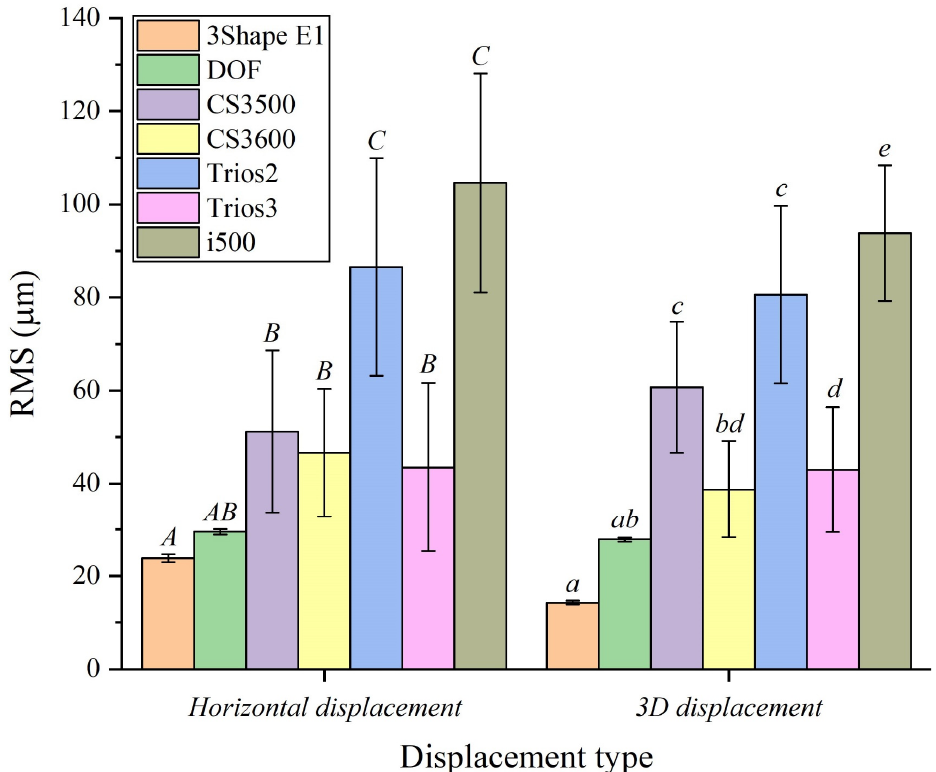
Figure 4. Horizontal displacement and 3D displacement according to the 3D scanners. Different letters indicate that the difference between the groups is significant by Tukey’s HSD post hoc testing ( P < 0.05). Both desktop and intraoral scanners had significant di ff erences in accuracy according to the types of teeth ( P < 0.001) (Table 2 and Figure 5). The intraoral scanner group tended to show worse accuracy with the second molar (Figure 5). On the other hand, the accuracy of the desktop scanner group did not tend to get worse towards the second molar and there was a little deviation (Figure